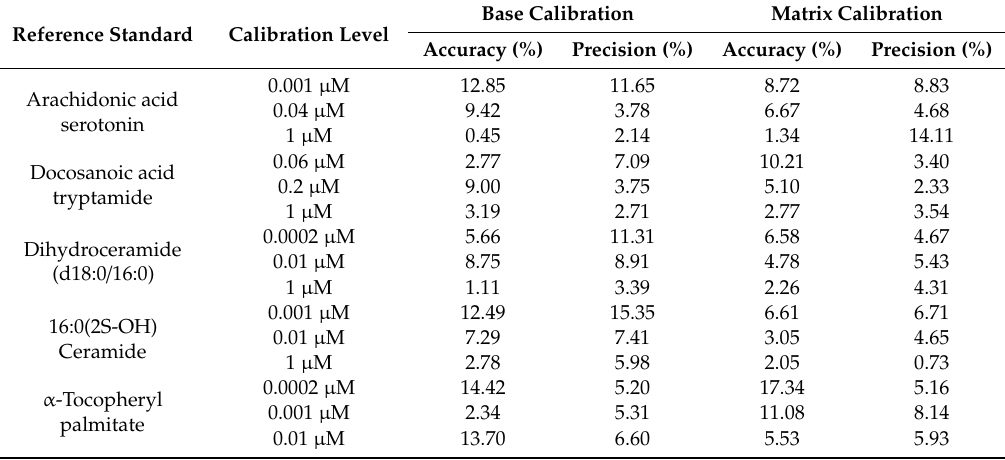
Table 2. Calculated accuracy and precision of the base and matrix calibration at three di ff erent concentration